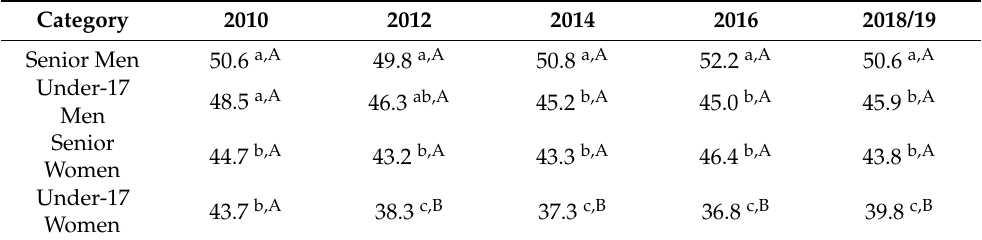
Table 4. Success rate of two-point shots (%).